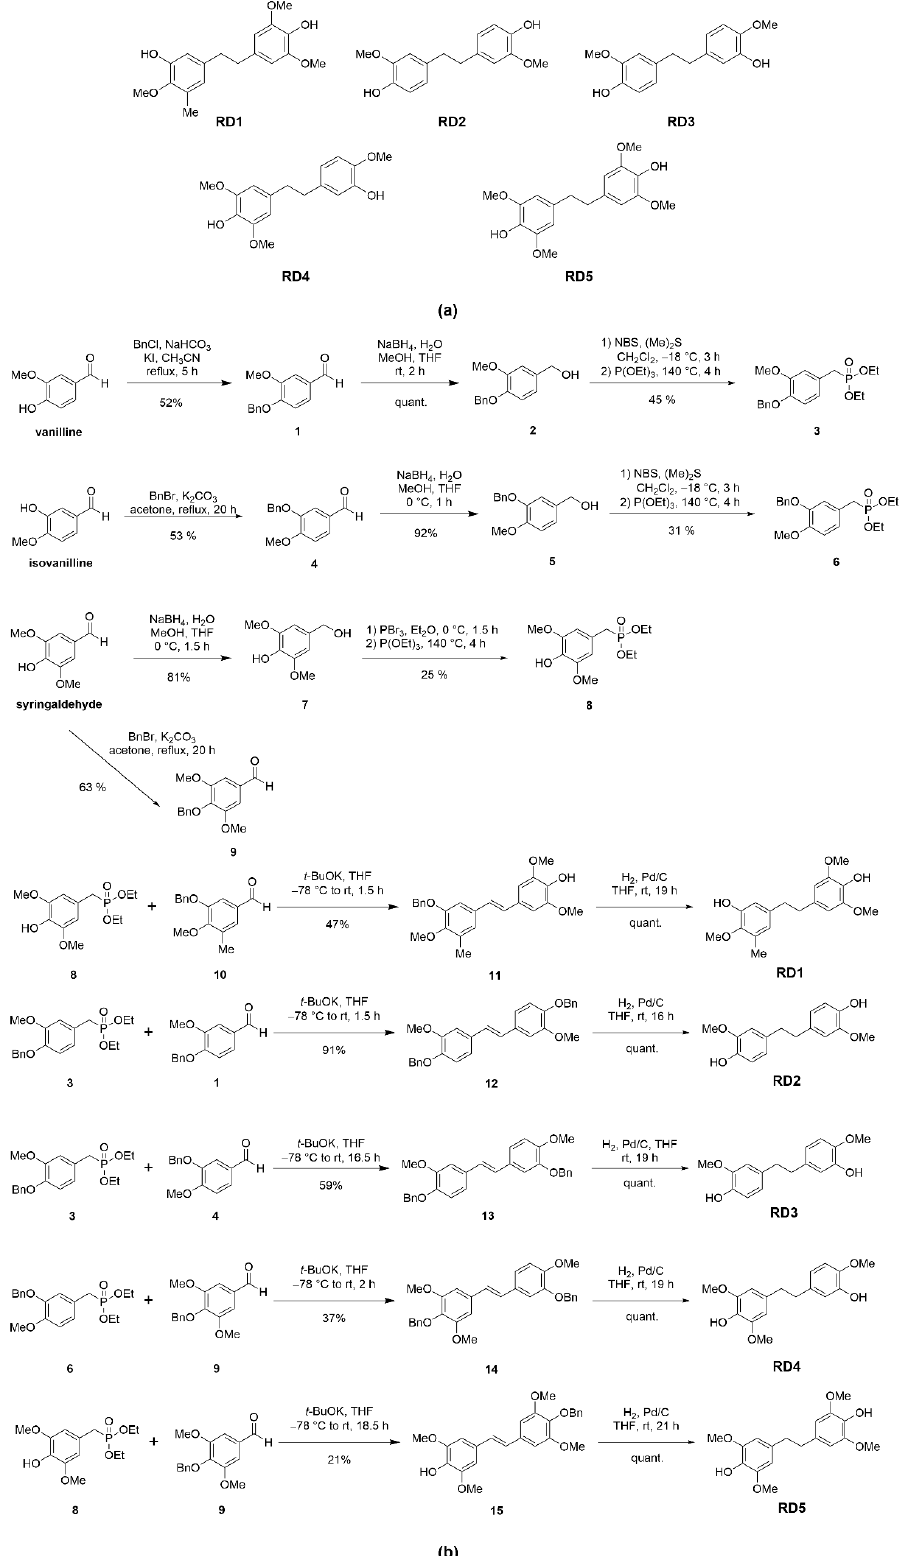
Figure 1. Synthesis and characterization of resveratrol derivatives. ( a ) Structure of five resveratrol deriva- tives’ compounds (RD1-RD5). ( b ) The synthesis method of five resveratrol derivatives’